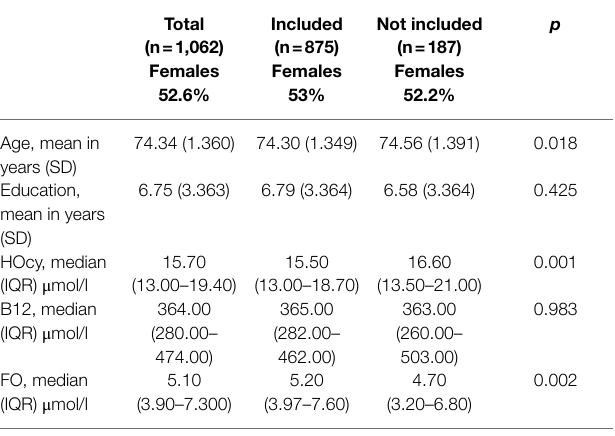
The mean values with standard deviation (SD) were compared using Student’s t test, while the median values with interquartile range (IQR) were compared using non- parametric rank analyses (the Mann–Whitney U test). Gender distribution did not differ significantly between the two groups. FI is not reported as the absence of fragility was the baseline selection criterion in this